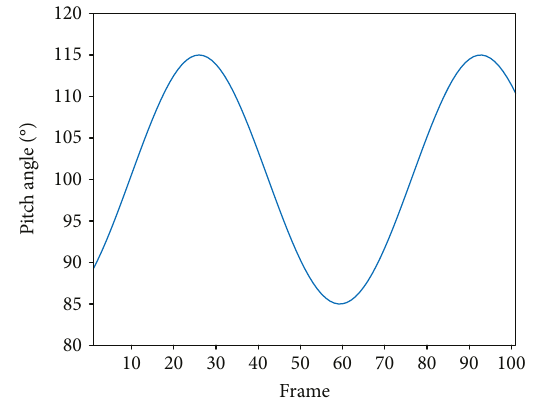
Figure 5: Variation in the pitch angle.